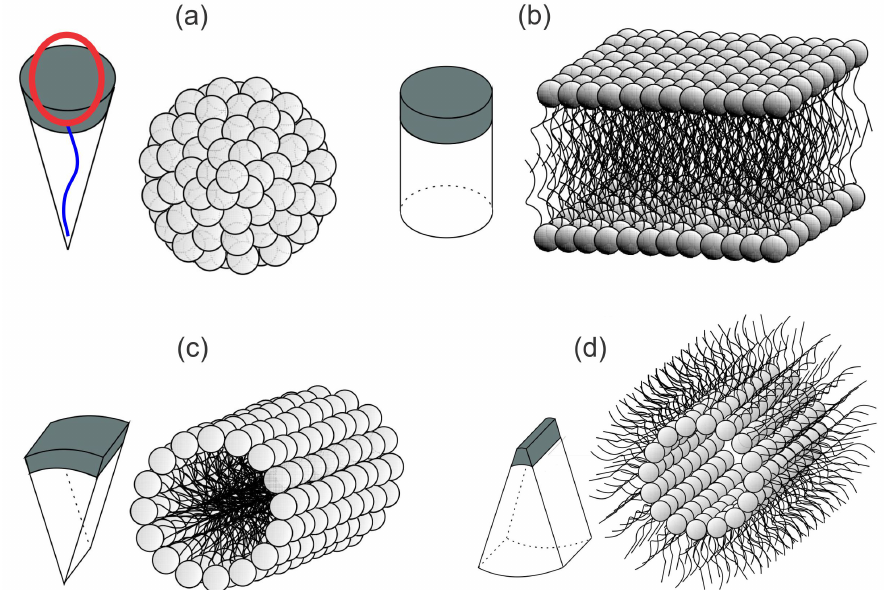
Figure 1. Schematically shown polymorphisms of phospholipid aggregates with the corresponding (isotropic and anisotropic) shapes of phospholipid molecules. Panel ( a ) shows a spherical micelle and a conically shaped lipid with a hydrophilic head (red) and a hydrophobic tail (blue). Figure also shows a phospholipid bilayer ( b ), a cylindrical micelle ( c ) and an inverted cylinder ( d ). Adapted with permission from ref. [5]. 2009